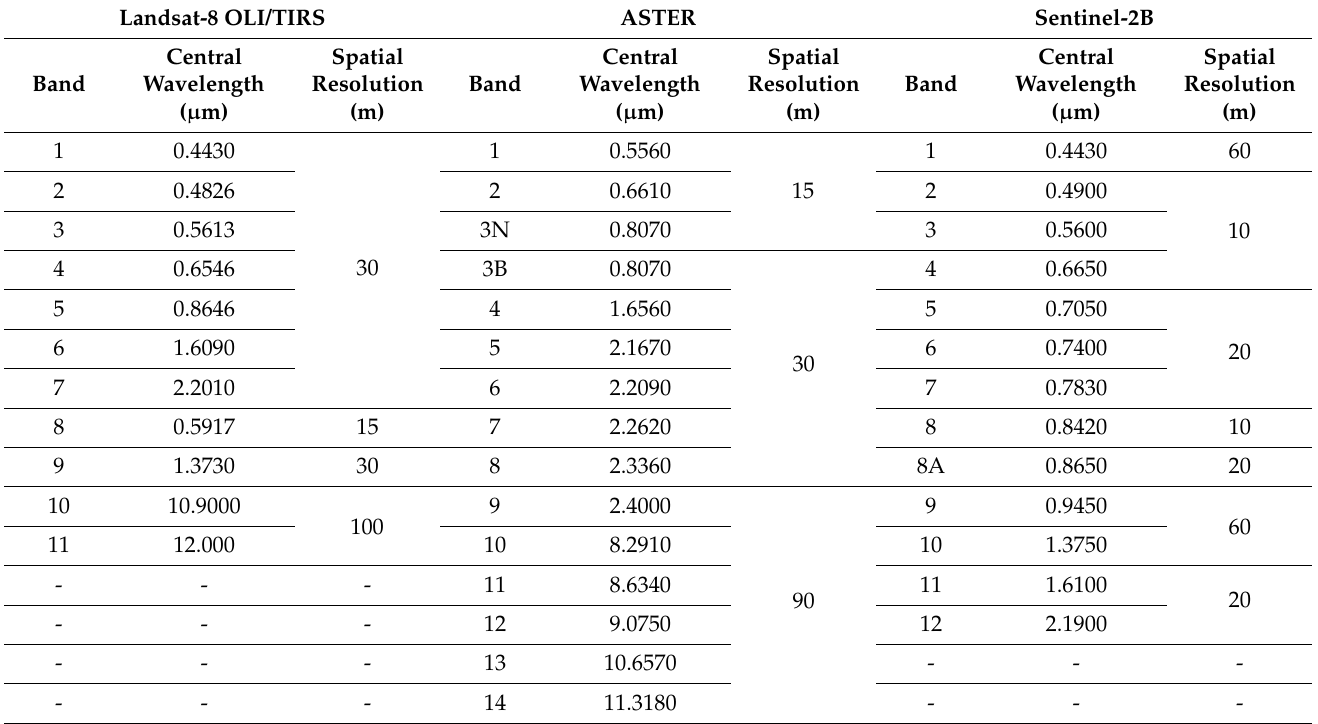
Table 1. Summarized characteristics of the Landsat-8 OLI/TIRS, Sentinel-2B and ASTER data [60]. Landsat-8 OLI/TIRS ASTER